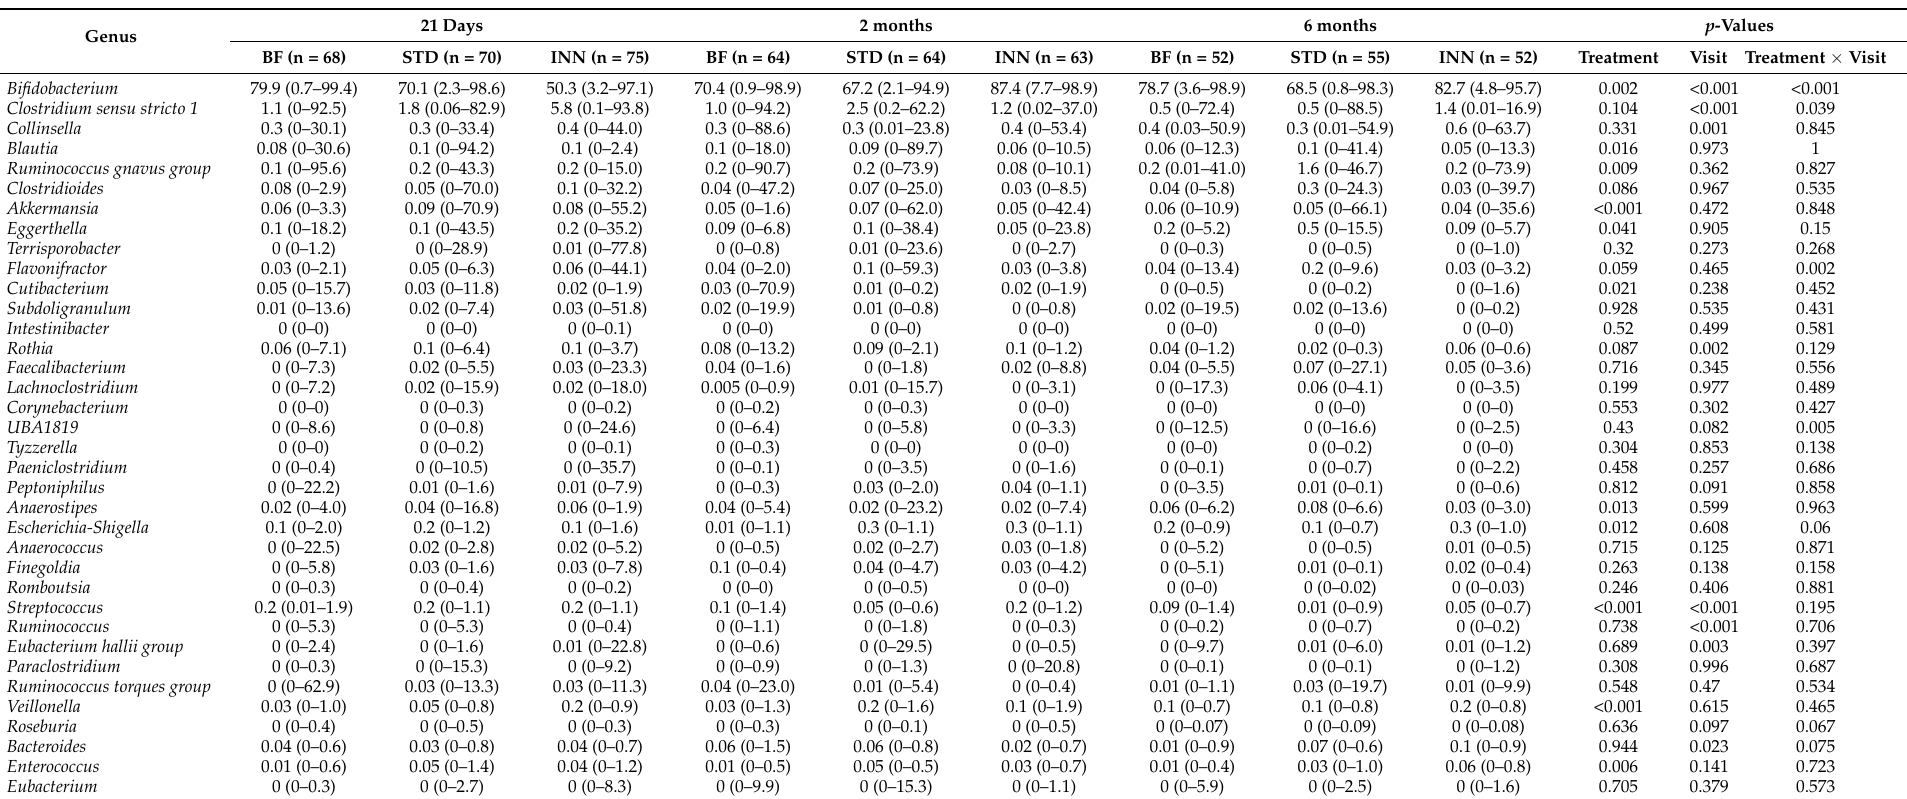
Table 2. Relative abundances at the genus levels of fecal bacteria in infants fed the INNOVA (INN) or a standard formula (STD) compared to exclusive breastfed (BF) infants up to 6 months of